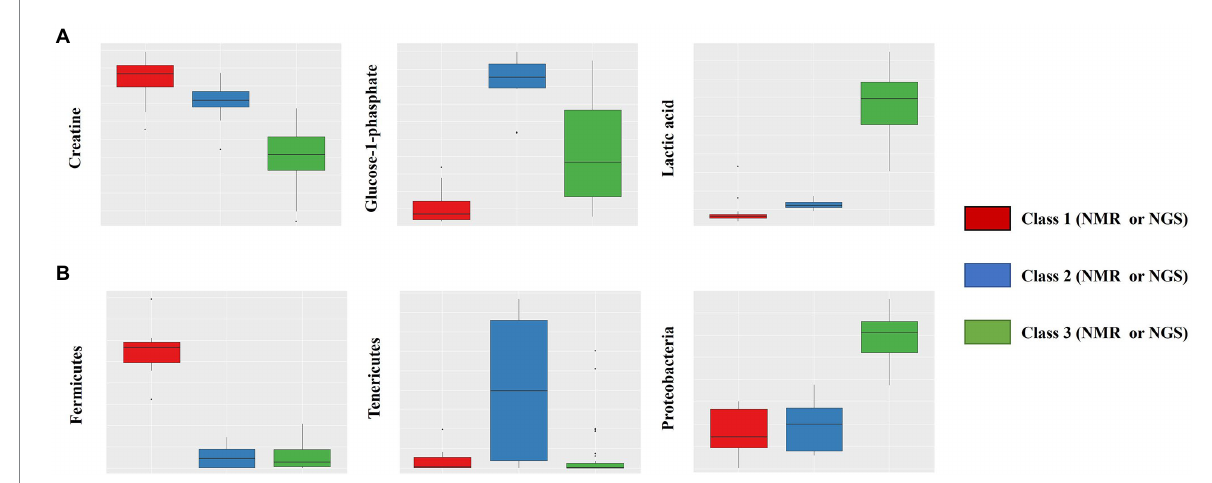
FIGURE 4 Box plot of important factors extracted using the i-means method. The upper row (A) shows the results of NMR data, which includes creatine, glucose-1-phosphate, and lactic acid (from the left). The lower row (B) shows the results of NGS data, which includes fermicutes, tenericutes, and proteobacteria (from the left). The vertical axis indicates the composition ratio to the total amount. The number of NMR data sets is 110, and the number of NGS datasets is 51 (excluding one). In the NMR panels, the numbers for classes 1, 2, and 3 are 24, 11, and 75, respectively. In the NGS panels, the numbers for classes 1, 2, and 3 are 7, 9, and 35, respectively.